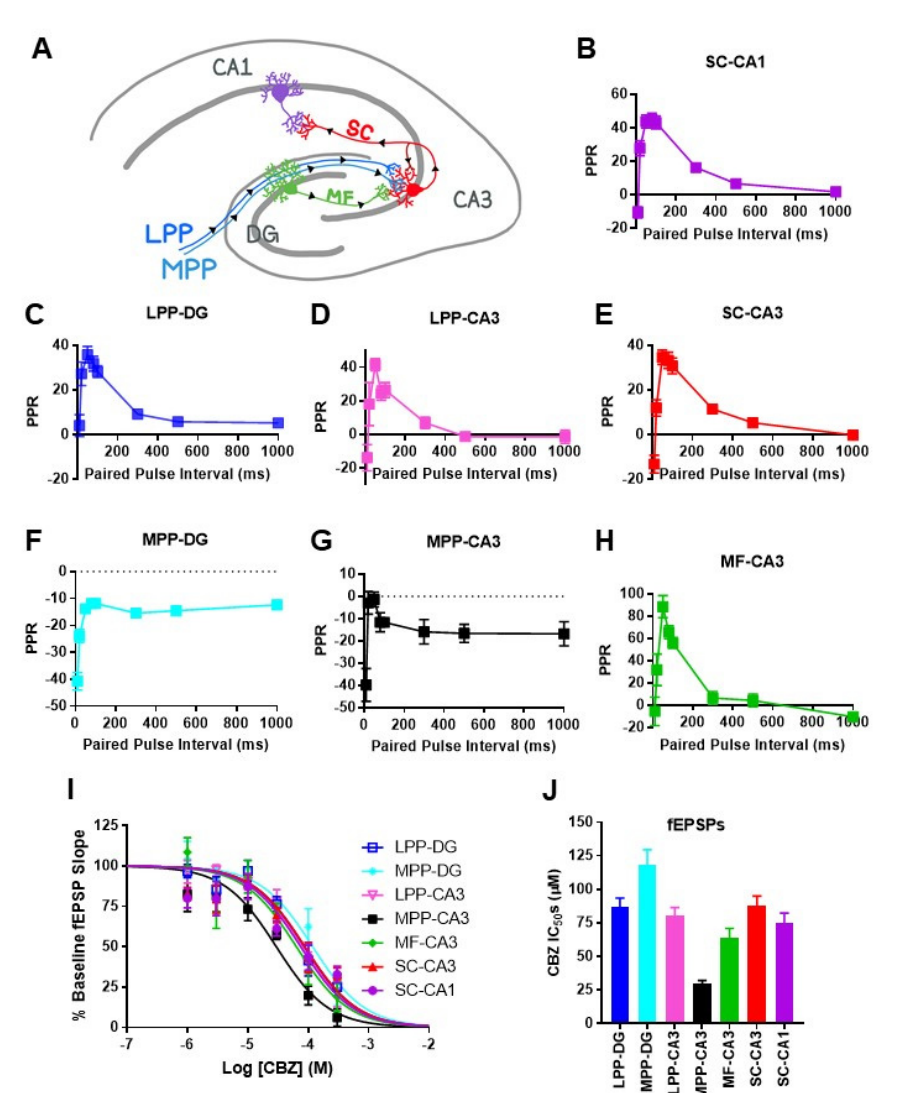
Figure 2. CBZ inhibits neurotransmission at multiple hippocampal synapses. ( A ) Illustration of hippocampal excitatory pathways and inputs from the entorhinal cortex via the lateral and medial perforant paths. ( B–H ) Identification of different synapses by characteristic short-term plasticity of excitatory postsynaptic field potentials (fEPSPs) to paired stimulations separated by increasing stimulations. ( I ) CBZ reduces fEPSPs at the seven synapses in a concentration-dependent manner. ( J ) Calculated half-maximal inhibitory concentrations (IC 50 s) from the concentration–response curves in I. IC 50 s: LPP – DG, 86.7 ± 7.6; MPP – DG, 118.3 ± 12.6; LPP – CA3, 80 ± 7.2; MPP – CA3, 29.5 ±